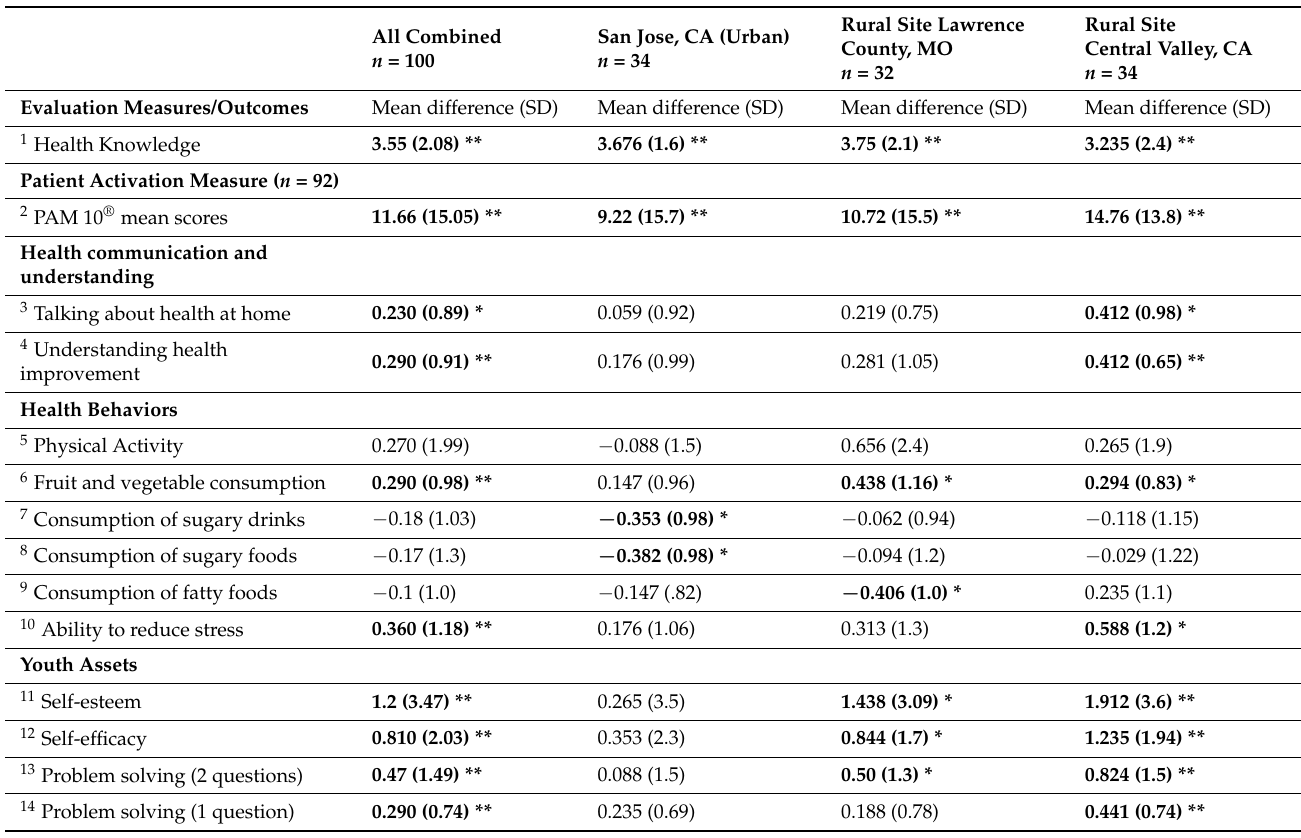
Table 3. Pre-Post Mean Differences in Outcome Measures of All Participants Combined ( n = 100), and by site (San Jose, CA; Lawrence County, MO; and Central Valley, CA), 2020–21. All Combined San Jose, CA (Urban) n = 100 n = 34